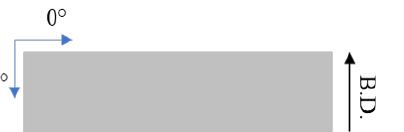
Figure 3. Residual stress measurement directions. The building direction is indicated by a black